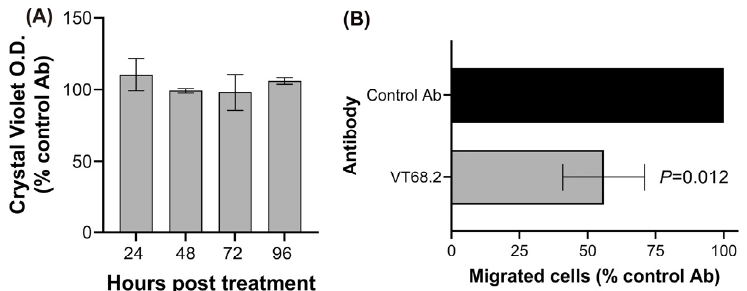
Figure 4. VT68.2 mAb did not induce direct cytotoxicity but inhibited the migration of MDA-MB- 231 cells and other cancer cell lines. ( A ) Cells were seeded at day 0 in the presence of 5 µg/mL of the isotype control or VT68.2 mAb. Cells were harvested after 24, 48, 72, and 96 h and then stained with crystal violet. The stain was then solubilized, and the absorbance was measured at 570 nm . The ODs of wells treated with VT68.2 mAb were normalized to those of a control mAb. Means ± SD of nor- malized percent O.D. of VT68.2 treated cells for all time points are shown. One-sample t -test com- paring each time point with 100% on log-transformed data showed no significant differences. ( B ) Cells were starved overnight in a serum-free medium, harvested using an enzyme-free buffer, then incubated with the isotype control, or VT68.2, transferred to transwell plates, and incubated at 37 °C for 48 h. The non-migrated cells on the top side of the membrane were wiped out, and migrated